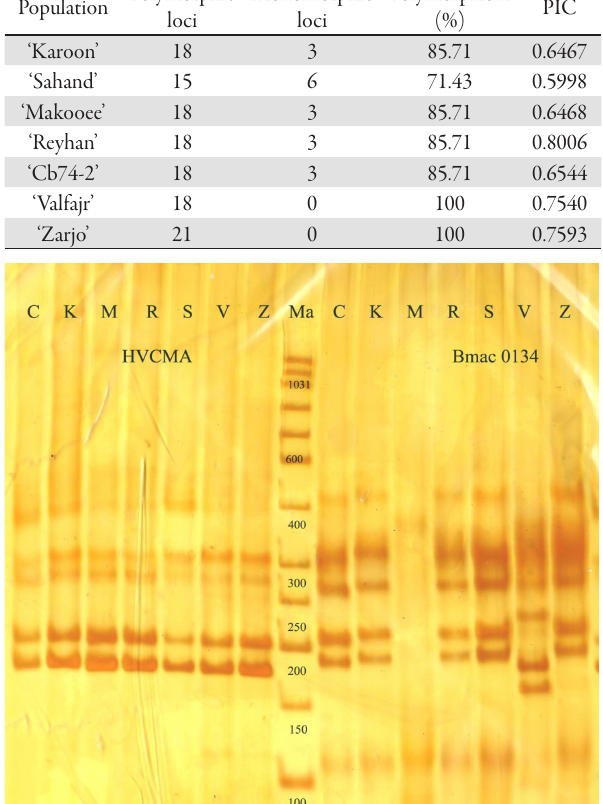
Fig. 1. SSR bands of various cultivars of Barley on 6% denaturat- ing polyacrylamide gel. (Capital letters = first letter of a